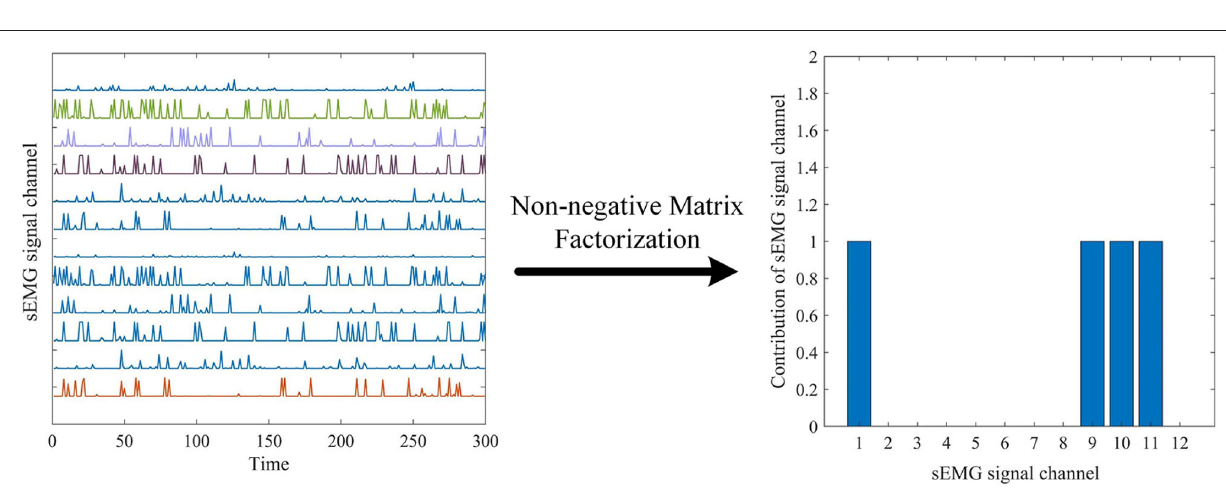
under the same lower limb movement. The model has good